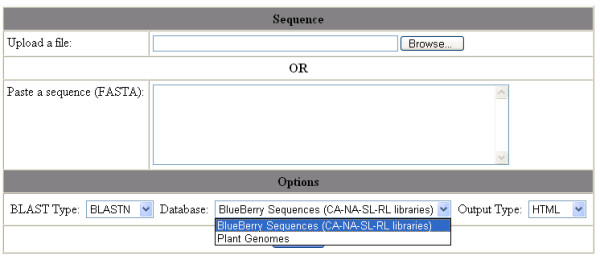
The Blast application allows users to cut and paste a sequence or to select a file containing a FASTA sequence and Blast the in-house sequences stored in BBGD or a collection of EST and genomic sequences from all plant species (kingdom Viridiplantae).